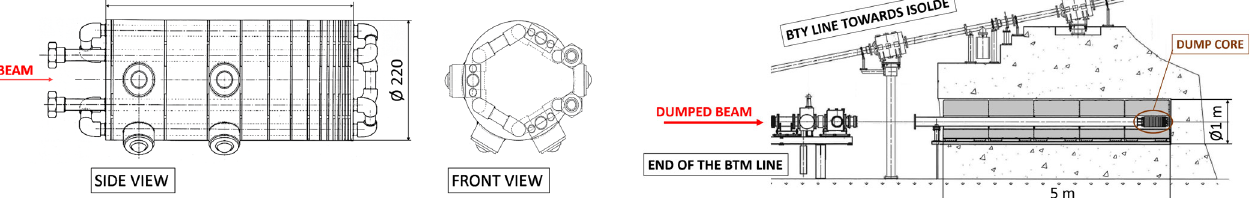
FIG. 3. Layout of the PSB dump area. On the left of the picture, the end of the BTM line and the BTY line toward ISOLDE. On the right, the original dump core, its shielding and beam pipe inserted in the dump